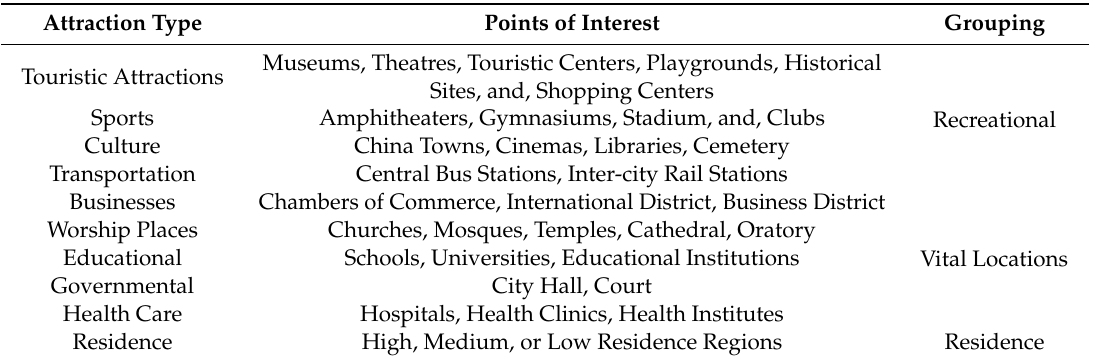
Table 11. Attractions Definition by